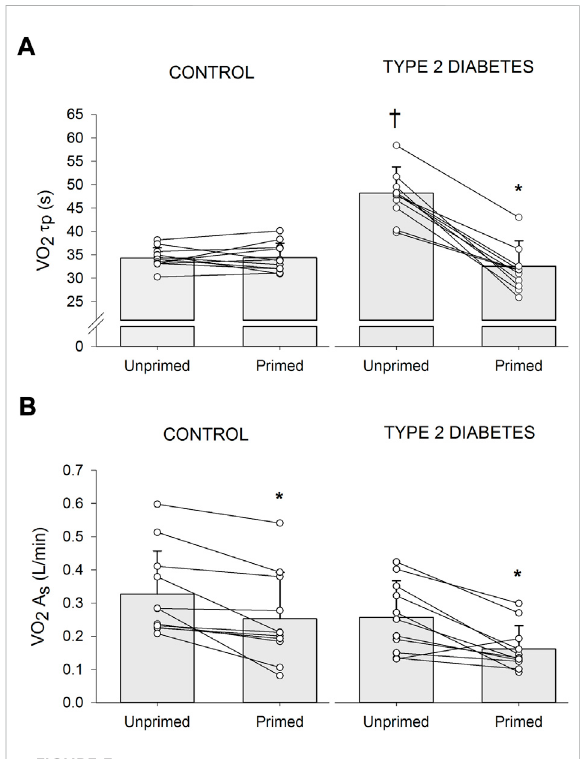
· constant of the primary phase of oxygen uptake (V O 2 τ p ) (A) and · · O 2 slow component (V O 2 A s ) (B) in participants amplitude of the V with type 2 diabetes ( n = 11) and healthy controls ( n = 11) during high-intensity cycling transitions without priming exercise (unprimed) and with priming exercise (primed). * p < 0.05 vs. unprimed within the same diabetes status group (i.e., within